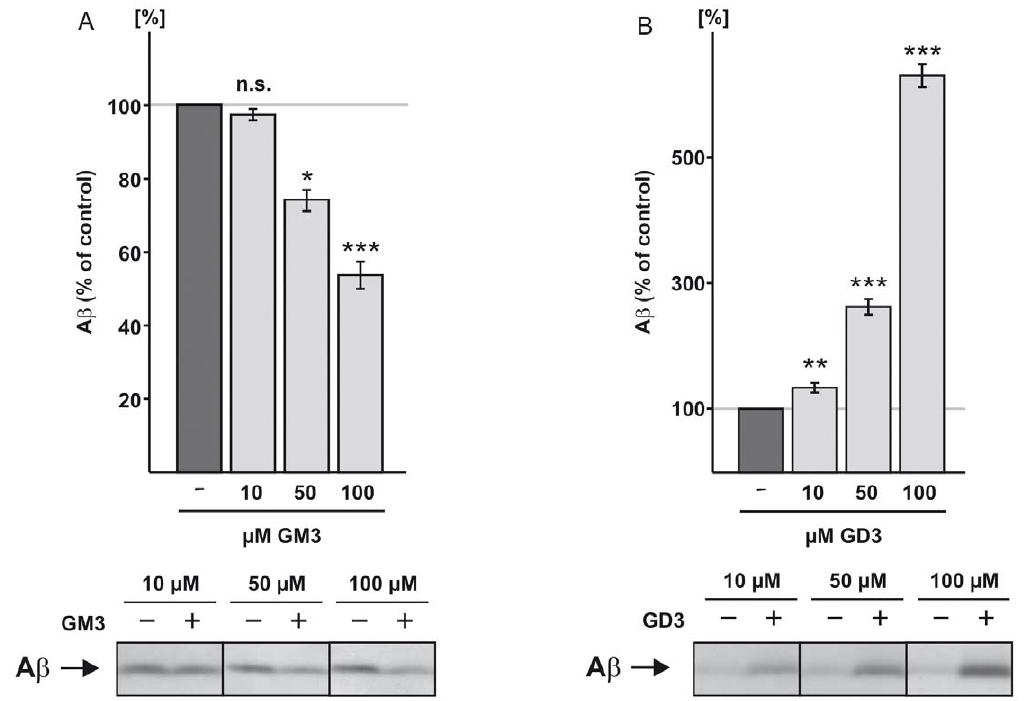
Figure 5. Effect of GM3 and GD3 on APP processing. ( A ) Dose-dependent effect of GM3 on A b production: COS7 cells stably transfected with SPC99, representing the b -secretase cleaved C-terminal fragment of APP, show a dose-dependent decrease in A b production in presence of GM3. A b levels were determined by IP and Western blot (WB) analysis. ( B ) Dose-dependent effect of GD3 on A b generation in SPC99 expressing COS7 cells. GD3 enhances A b generation dose-dependently. A b levels were determined by IP and WB